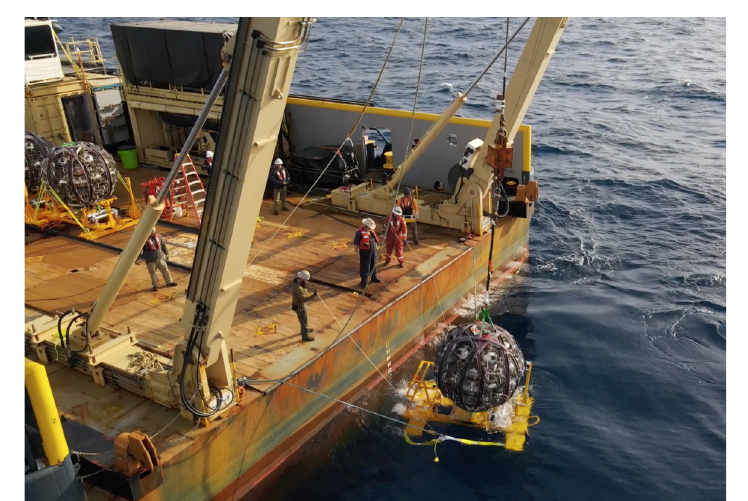
Figure 2. Left: The block diagram of the ARCA Junction Box. A titanium mainframe hosts all the instrumentation and connectors. To improve reliability, the number of connections in water is min- imised. The sub-systems, the control and power electronics plus the optical circuits are fully contained in a unique cylinder with a volume of about 100 litres. Right: A JB ready for deployment during a sea campaign. The ROV mateable connectors (in orange) are visible in the front panel; they provide input and output connectivity underwater. Figure 3. A detection unit enters into the sea. It will go down 3500 m and be deployed on the seafloor. Using a ROV it will be connected to a Junction Box through an electro-optical cable. Finally, the unfurling of the spherical structure will be triggered and the DU will get its final vertical